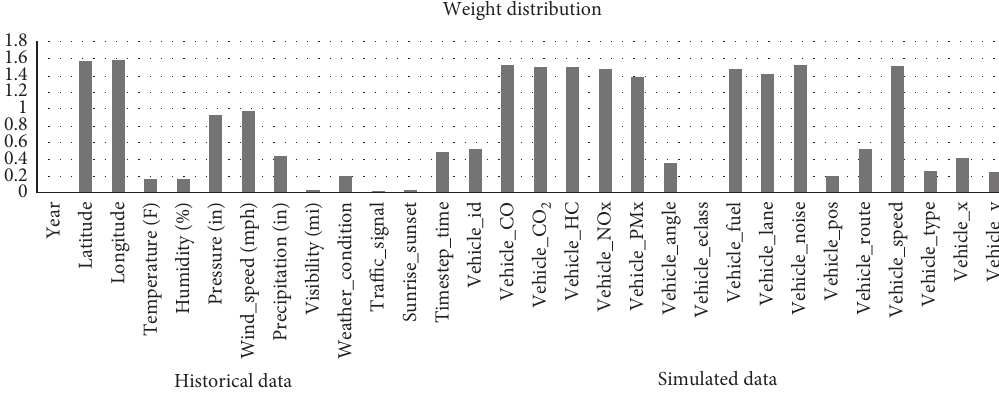
Figure 5: Feature weight distribution in case of incident type